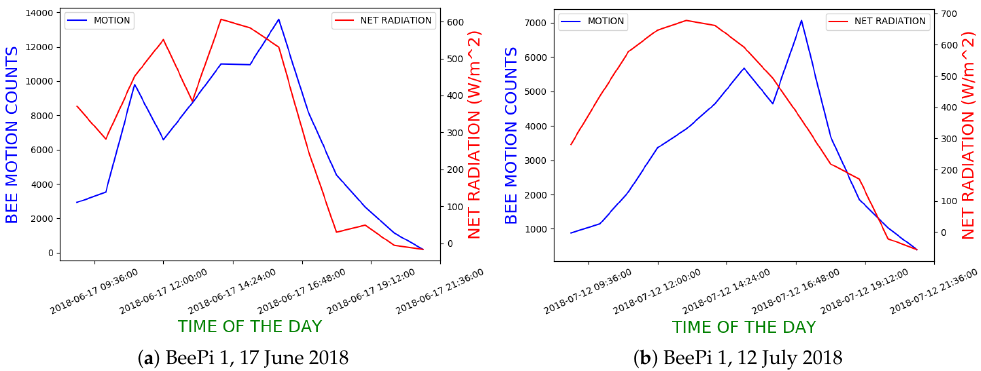
Figure 12. Alignment of net radiation measurements from USU UCC weather station with BeePIV motion counts from videos from BeePi monitor 1 in Logan,